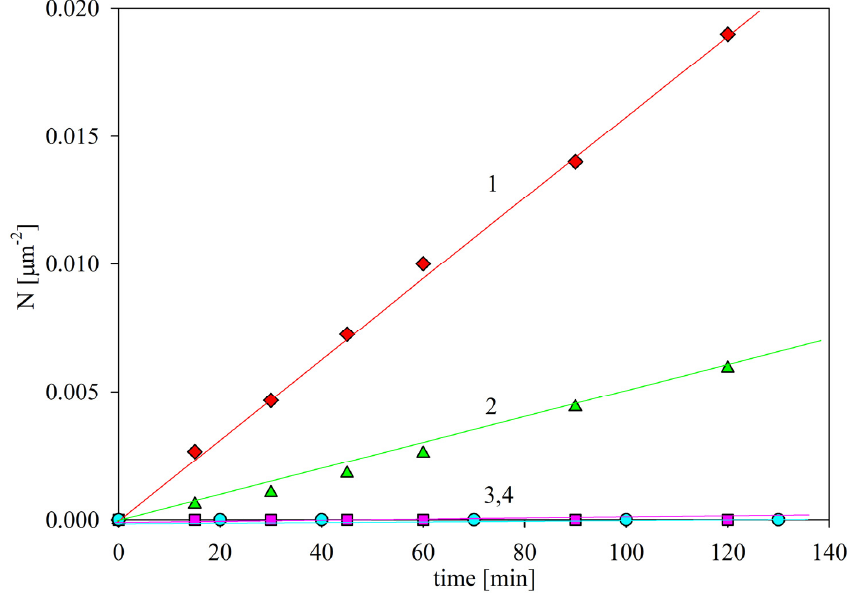
Figure 6. The kinetics of SAL immunolatex particle deposition in bare mica in the OBIJ microfluidic cell, shown as the dependence of the surface concentration on the deposition time. Particle bulk concentration, 100 mg L − 1 , 1 mM NaCl; flow rate 2.5 × 10 − 3 cm 3 s − 1 . The points show the results ob- tained for: 1. pH 3.5 ( ♦ ); 2. pH 4 ( ▲ ); 3. pH 5.5 ( ■ ) and 4. pH 7.4 ( ● ). The solid lines are linear fits